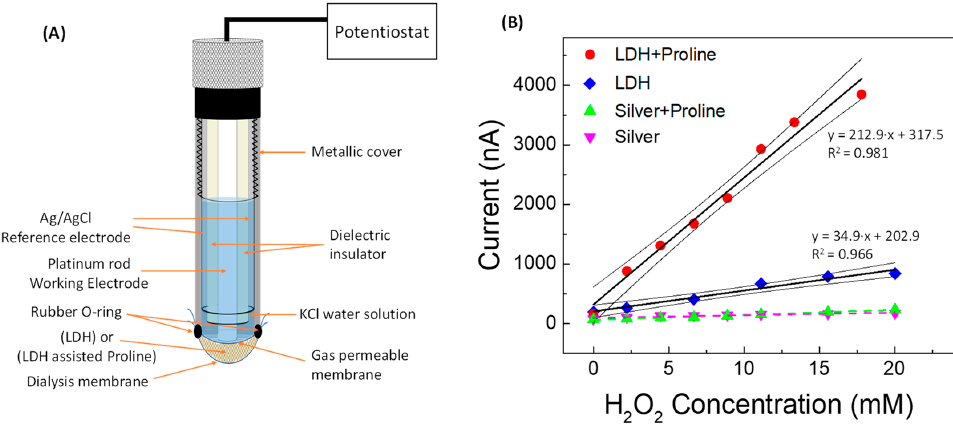
Figure 7. ( A ) Schematic of the non-enzymatic catalytic Clark-type proline-assisted (or non-assisted) LDH amperometric sensor and ( B ) straight line calibration curve vs. H 2 O 2 concentration obtained using Clark sensor with ( ● ) proline-assisted LDH, ( ◆ ) LDH without proline, ( ▲ ) proline-assisted silver paste, and ( ▼ ) silver paste without proline.